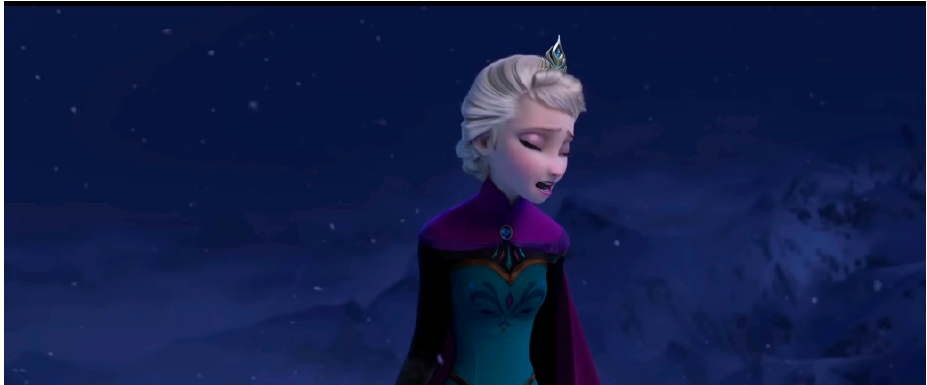
Figure 2. ‘The wind is howling like this swirling storm inside’ (Walt Disney Animation Studios 2013a).